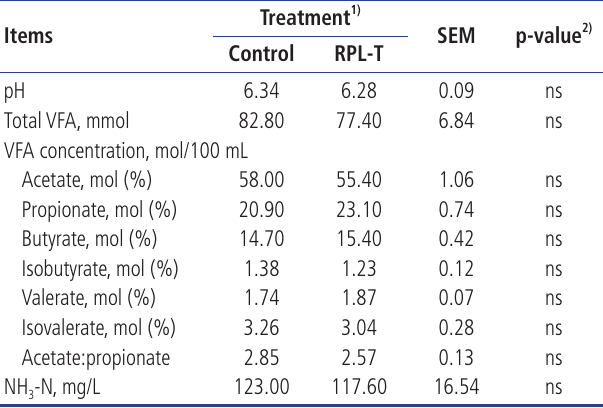
Table 2. Apparent crude protein loss in each segment of the gastrointestinal tract in Korean native steers fed basal diet and RPL-T